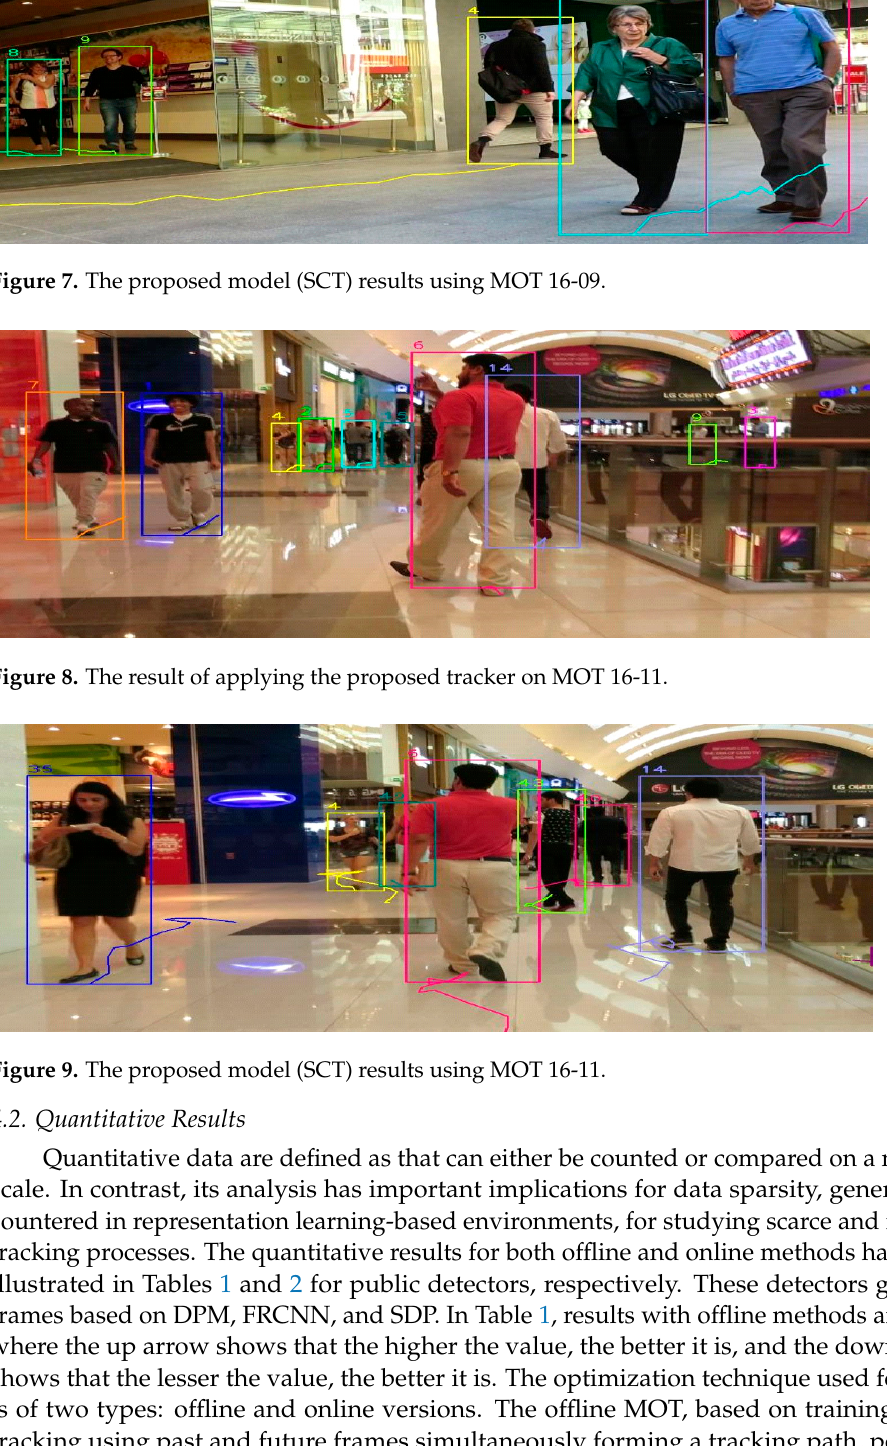
Figure 6. The proposed model (SCT) results using MOT 16-09.